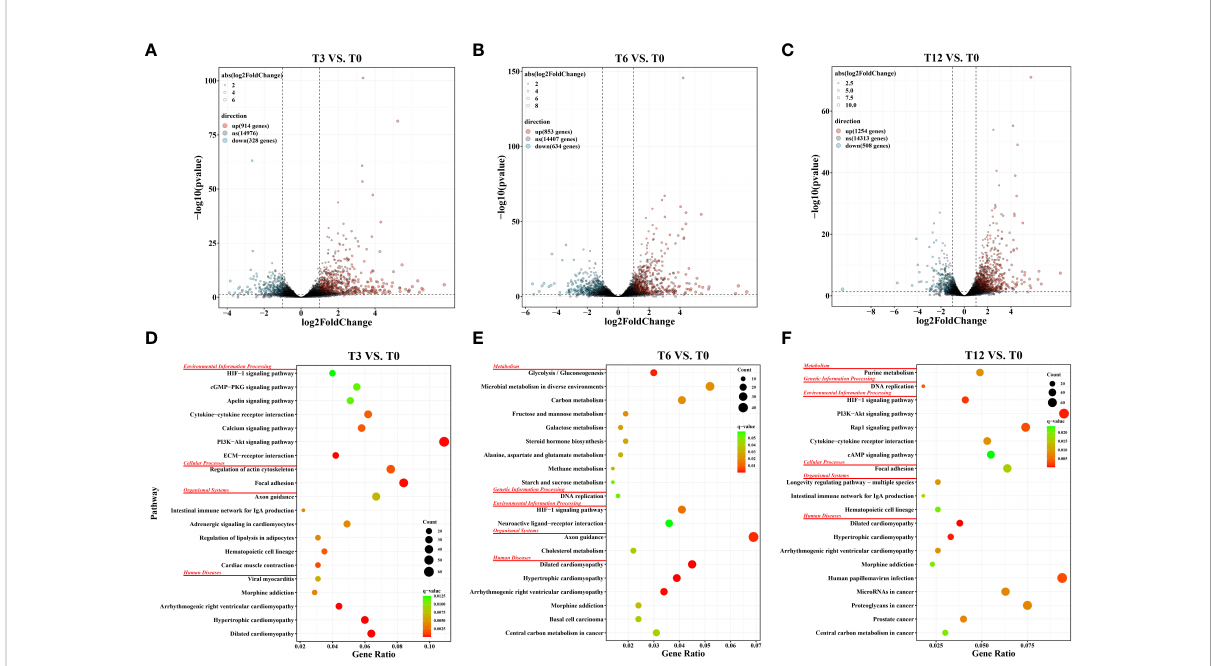
FIGURE 1 Statistics of differentially expressed genes (DEGs) and KEGG pathway enrichment analysis in gills of spotted sea bass at different time points after hypoxia. (A) Volcano plot of DEGs in the comparison group of T3 vs. T0; (B) Volcano plot of DEGs in the comparison group of T6 vs. T0; (C) Volcano plot of DEGs in the comparison group of T12 vs. T0; (D) KEGG pathway enrichment analysis of DEGs in the comparison group of T3 vs. T0; (E) KEGG pathway enrichment analysis of DEGs in the comparison group of T6 vs. T0; (F) KEGG pathway enrichment analysis of DEGs in the comparison group of T12 vs.